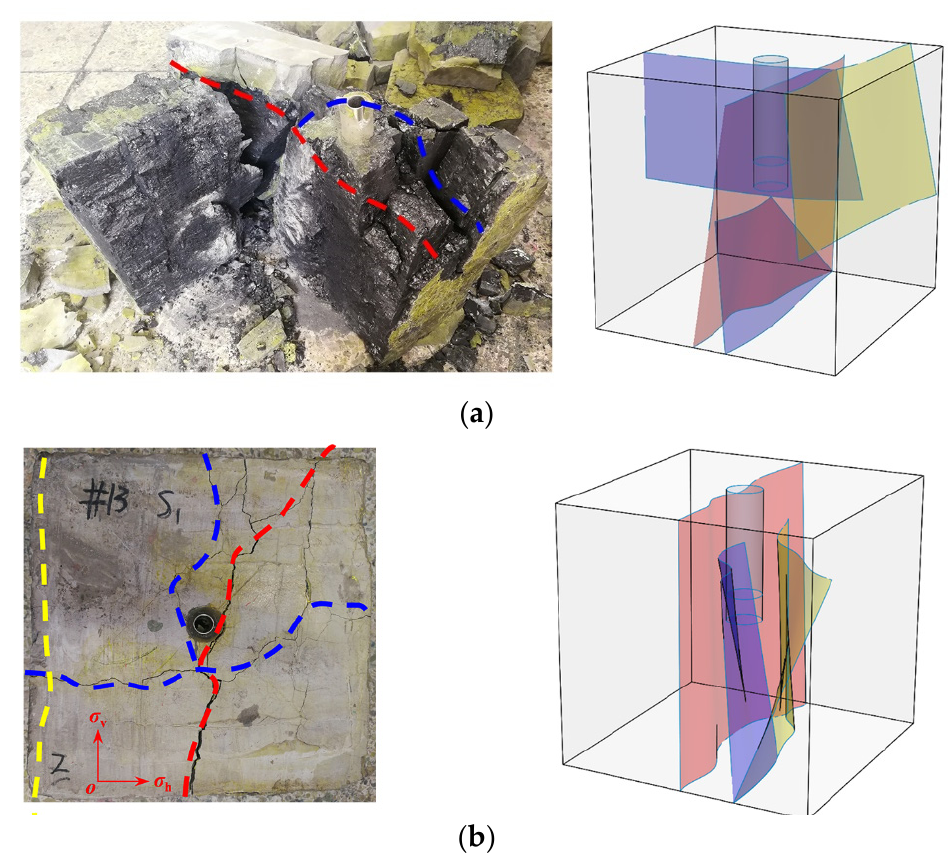
Figure 7. Effect of the concentration of TPA on THF morphology: ( a ) fracture morphology of sample 4#; ( b ) fracture morphology of sample 5#.